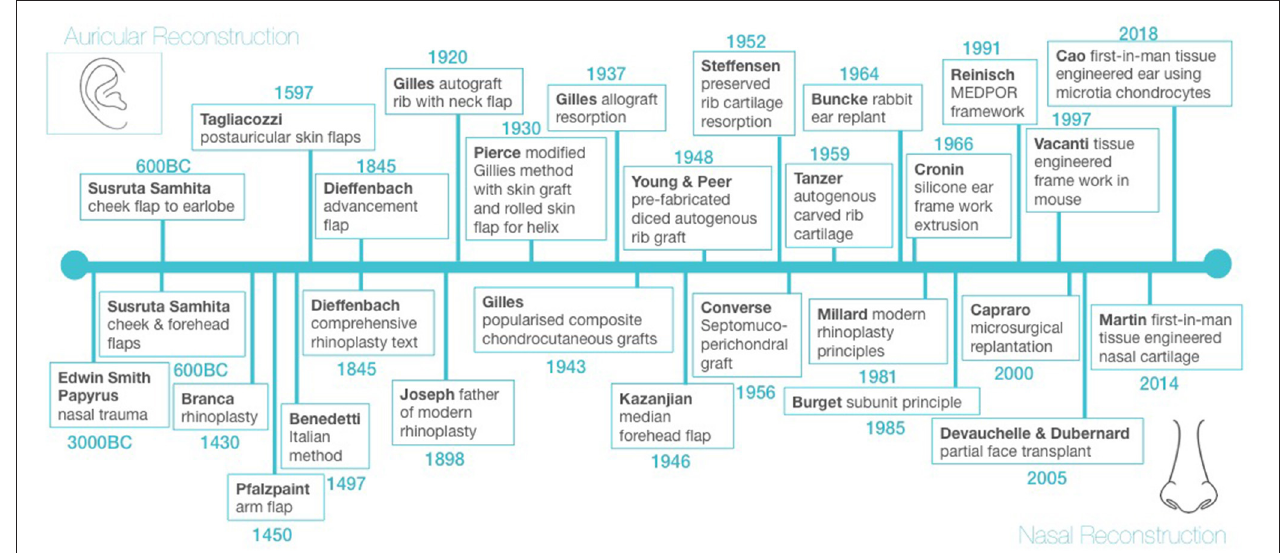
FIGURE 1 | History of cartilaginous based facial